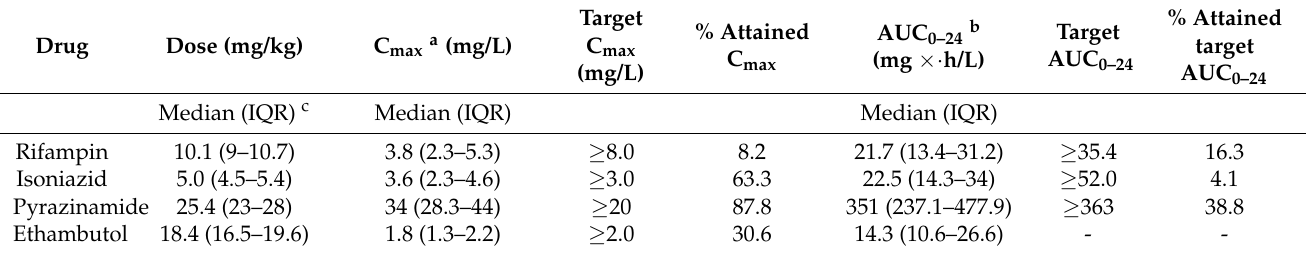
Table 1. Summary of antituberculous drug exposure parameters and desired targets as extracted from Rao et al.